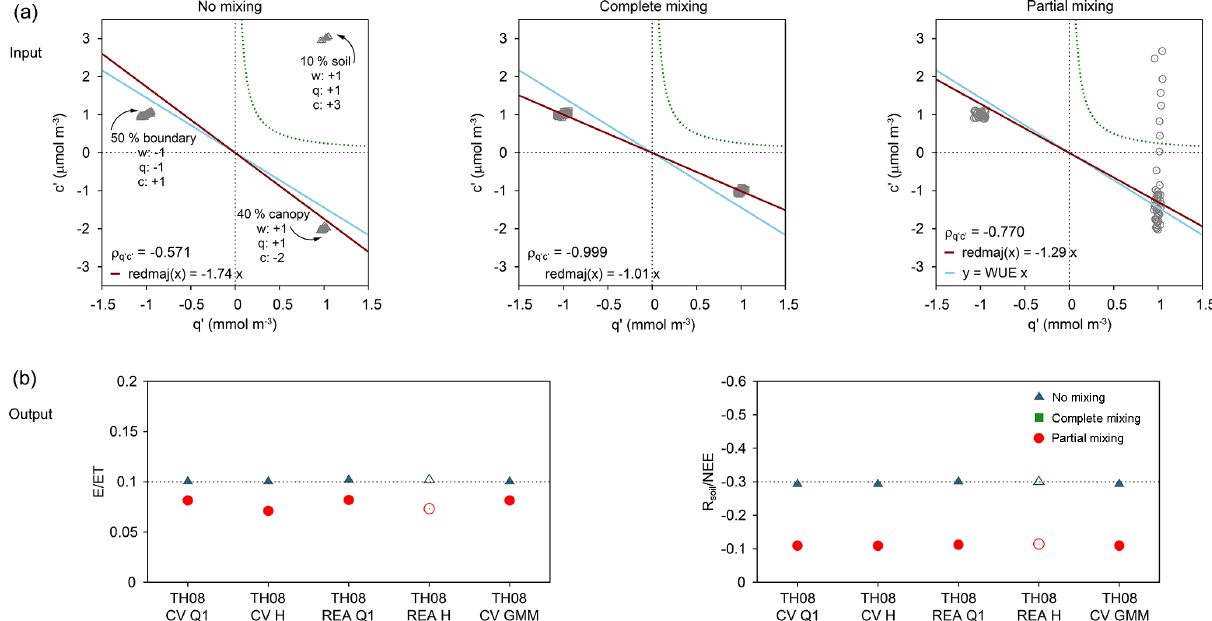
Figure 7. (a) Setup of the conceptual model for synthetic fluctuations ( q (cid:48) and c (cid:48) ) originating from the soil, canopy, or boundary layer with differing degrees of mixing (no, complete, or partial mixing between soil and canopy sink–source) including water use efficiency (WUE =− 1.444µmolmmol − 1 =− 3.53mgg − 1 ; blue line), reduced major axis regression (red line) after Webster (1997), hyperbolic thresh- old criterion after Thomas et al. (2008; TH08) ( H = 0 . 25; green dashed line), and correlation coefficient between q (cid:48) and c (cid:48) ( ρ q (cid:48) c (cid:48) ). (b) True known partitioning ratios (dashed line) and source partitioning results from all TH08 method versions (see text for description) for each degree of